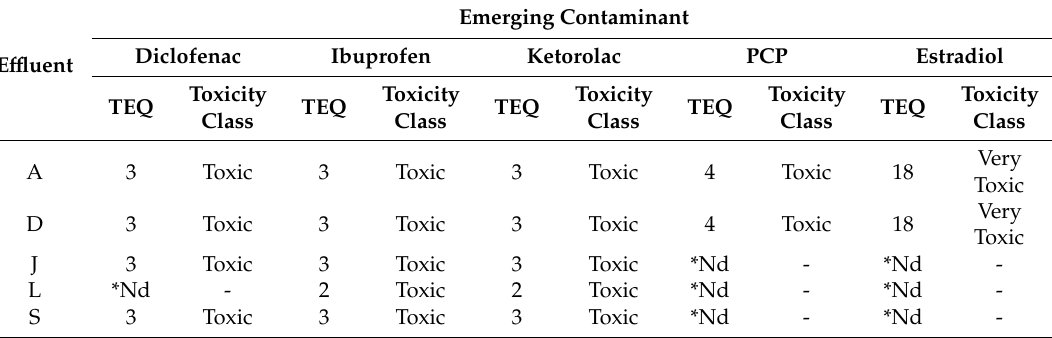
Table 4. Ecotoxicological assessment for